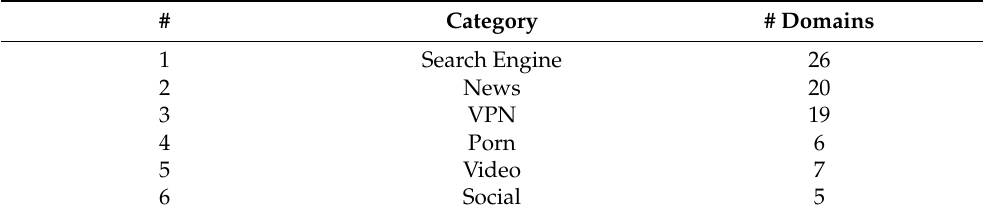
Table 1. Number and category of blocked domain names in